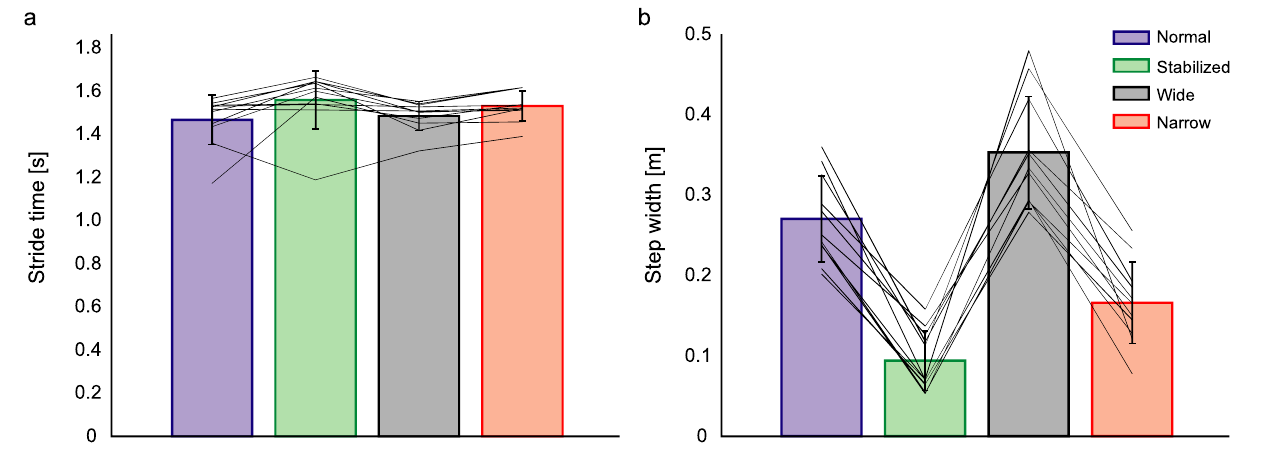
Figure 1. Spatiotemporal parameters of gait during normal walking (blue), walking with external lateral stabilization (green), wide-base walking (black) and narrow-base walking (red). Mean values (bars), standard deviation (error bar) and participants individual changes across conditions (lines) for the stride time ( a ) and stride width ( b ) for the four